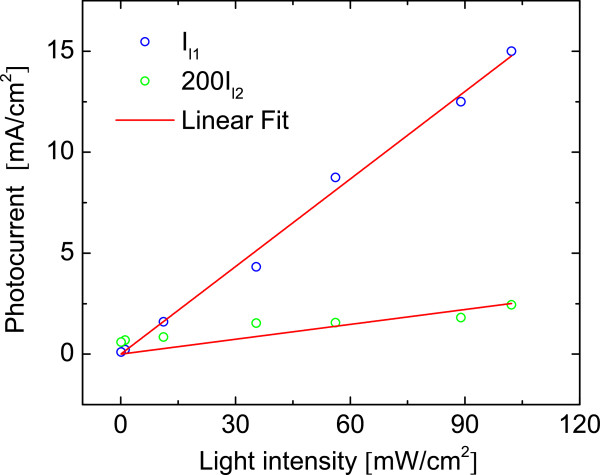
Fit results. Values of photocurrents Il1and Il2obtained from fitting experimental data with the model (Figure 5) as a function of illumination intensity. The values of Il2are scaled for a better representation. A linear fit for both parameters is also included.